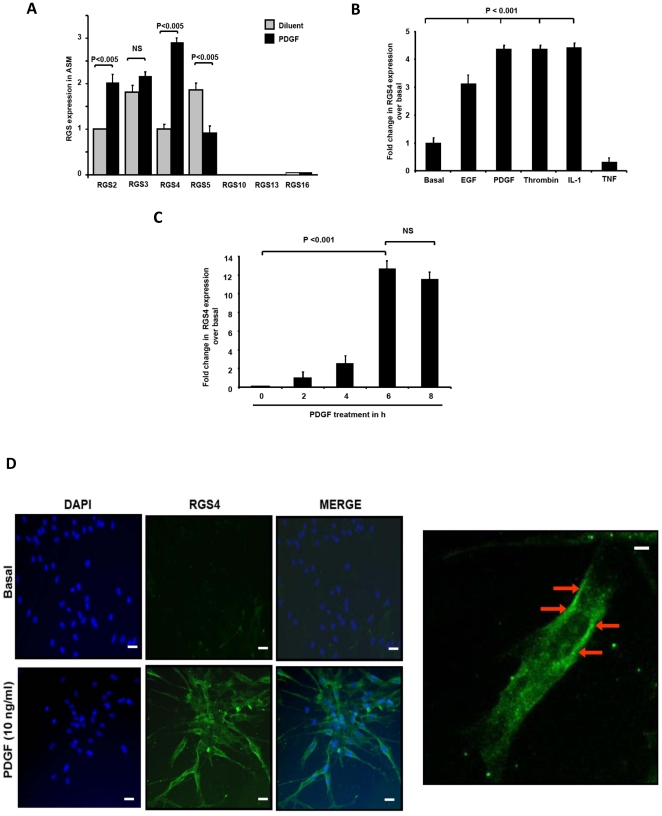
Human airway smooth muscle (HASM) mitogens induce RGS4 expression.(A) HASM cells express RGS mRNAs. RGS expression was determined by real-time PCR in HASM cells left untreated or treated with PDGF for 2 h. Data presented are mean ± SEM of 3 separate experiments performed in triplicate using Gadph as an internal control, relative to RGS2 in untreated cells, set as ‘1’. (B) Analysis of RGS4 expression in HASM cells treated with mitogens such as EGF (1 ng/ml), PDGF (10 ng/ml), thrombin and cytokines by real-time PCR. Data (mean ± SEM) of 5 independent experiments. (C) Kinetics of PDGF-mediated RGS4 mRNA expression as a function of time. Values (mean ± SEM of 3 separate experiments performed in triplicate) are relative to those of untreated cells, set as ‘1’ (D) RGS4 expression in untreated (top) or PDGF-treated (bottom) HASM cells immunostained with polyclonal anti-RGS4 followed by Alexa Fluor 488-conjugated anti-IgG and DAPI. Left: High power (650×) visualization of immunostaining with an anti-RGS4 antibody shows plasmalemma staining of RGS4 protein after PDGF. These data are representative of triplicate wells in 2 separate cell lines. Bars represent 50 microns.